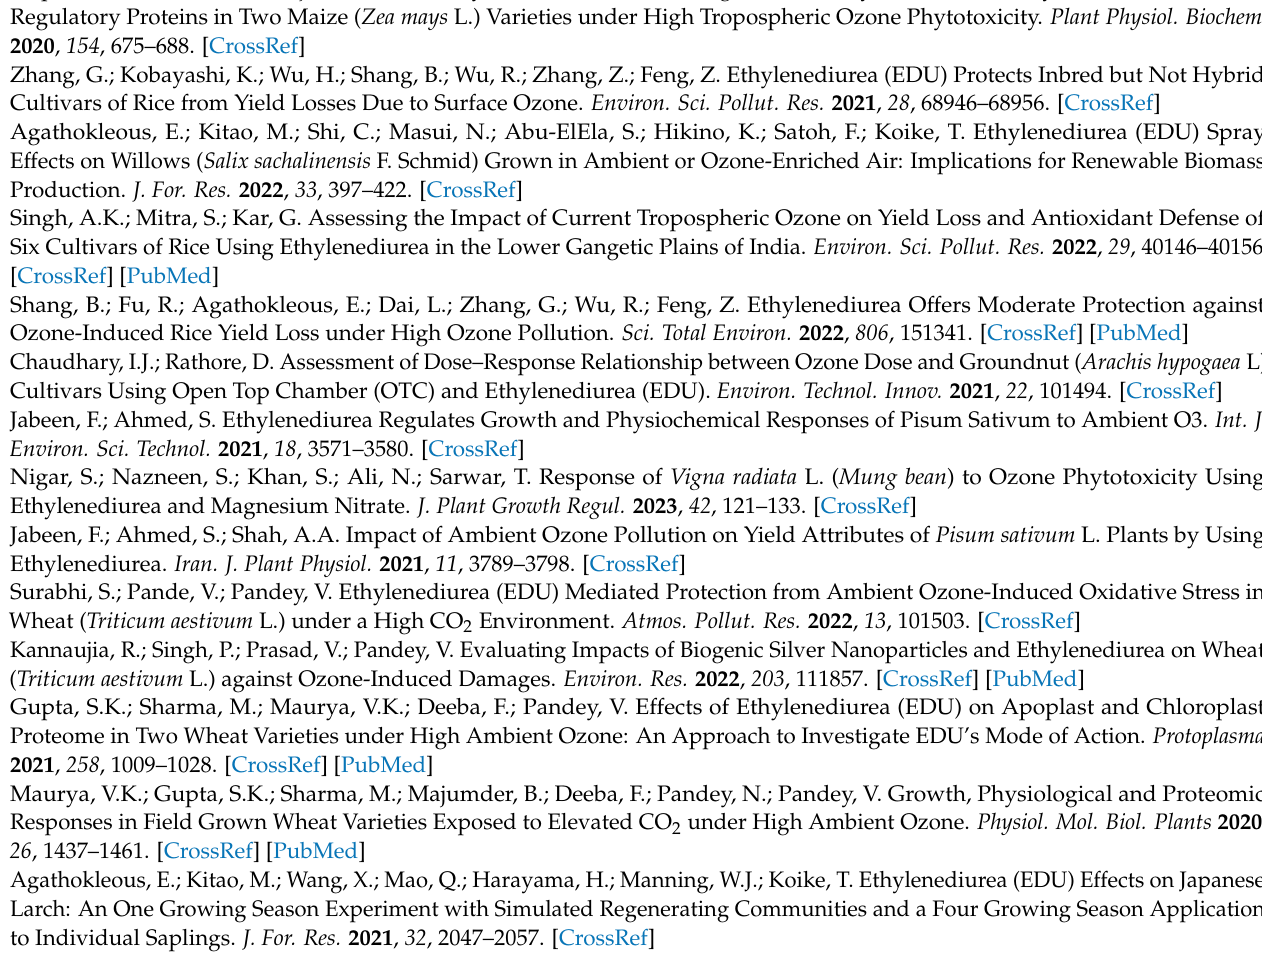
Table S1: The results of preliminary work. Table S2: The relative water content wheat shoots treated with compounds E1–E4 and TDZ under water stress